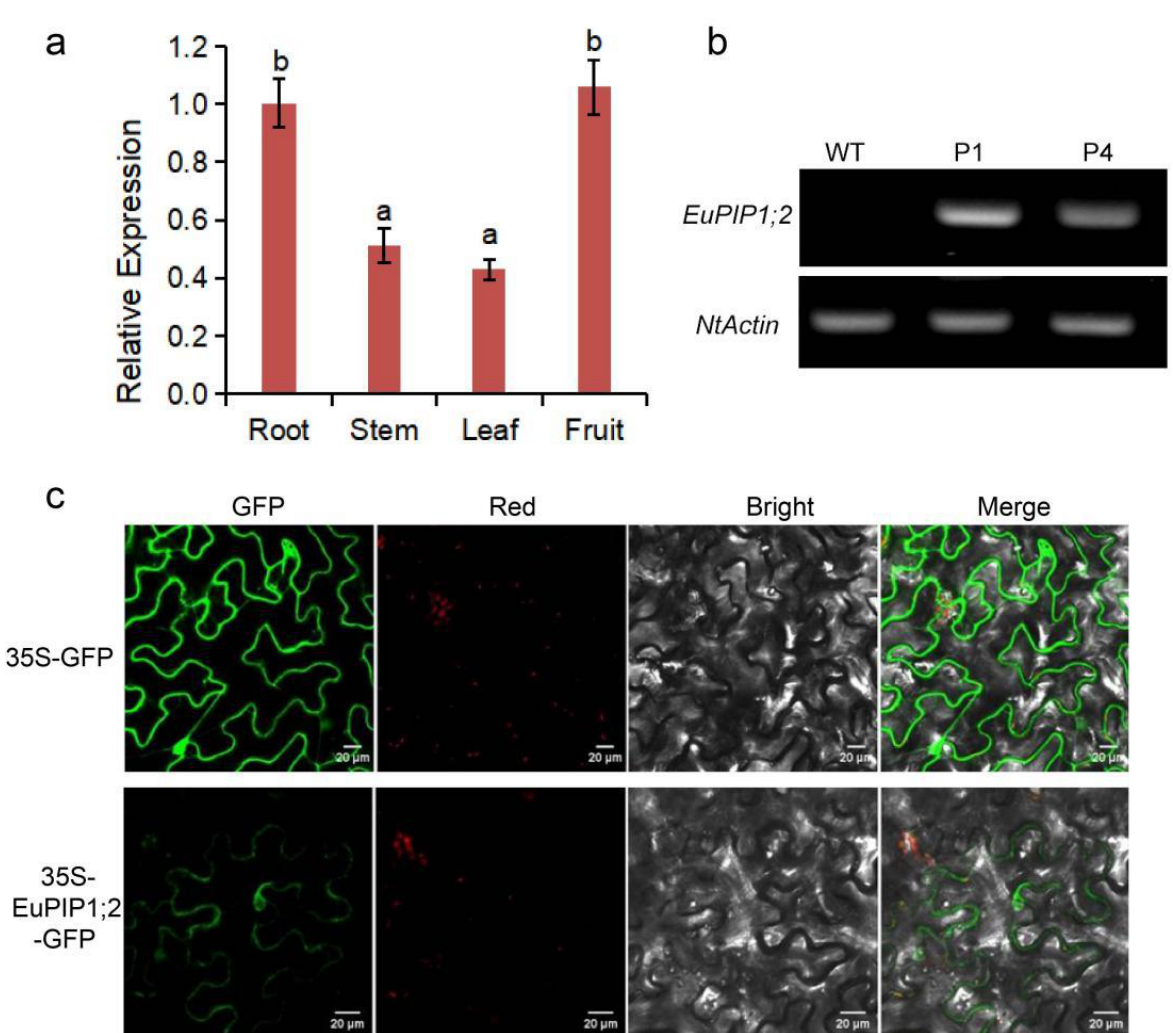
Figure 3. ( a ) Relative expression level of EuPIP1;2 in four organs of Eucommia ulmoides . ( b ) Expres- sion analysis of the EuPIP1;2 and NtActin in wild-type (WT) tobacco and transgenic lines. ( c ) Sub- cellular localization of EuPIP1;2 in cells of Nicotiana benthamiana leaves.